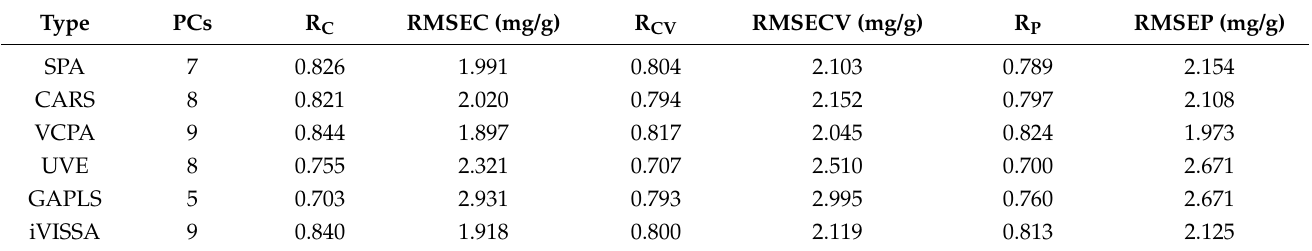
Table 3. PLSR models at different characteristic wavelengths of chlorophyll